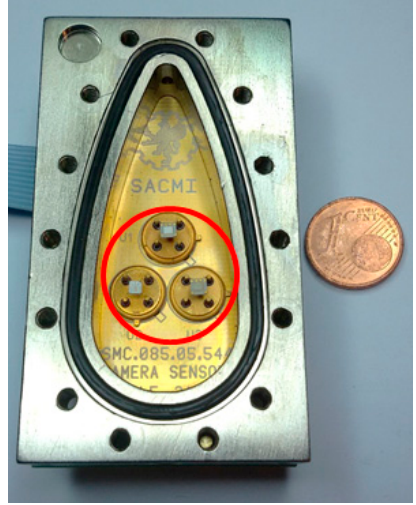
Figure 1. Open sensors chamber showing three gas